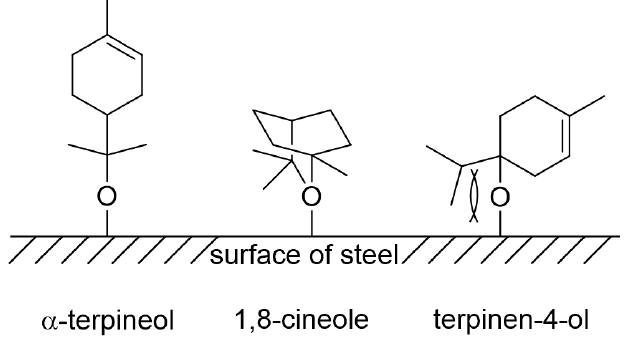
Figure 16. Adsorption of the main constituents on the surface of steel.